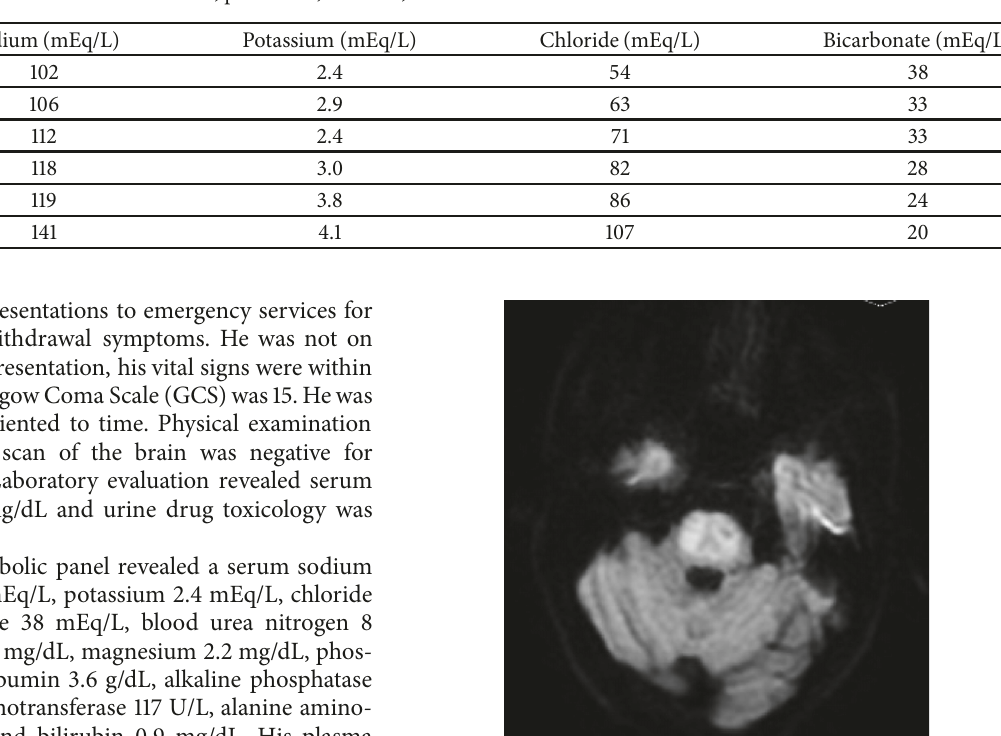
Table 1: Serum sodium, potassium, chloride, and bicarbonate concentrations over time.